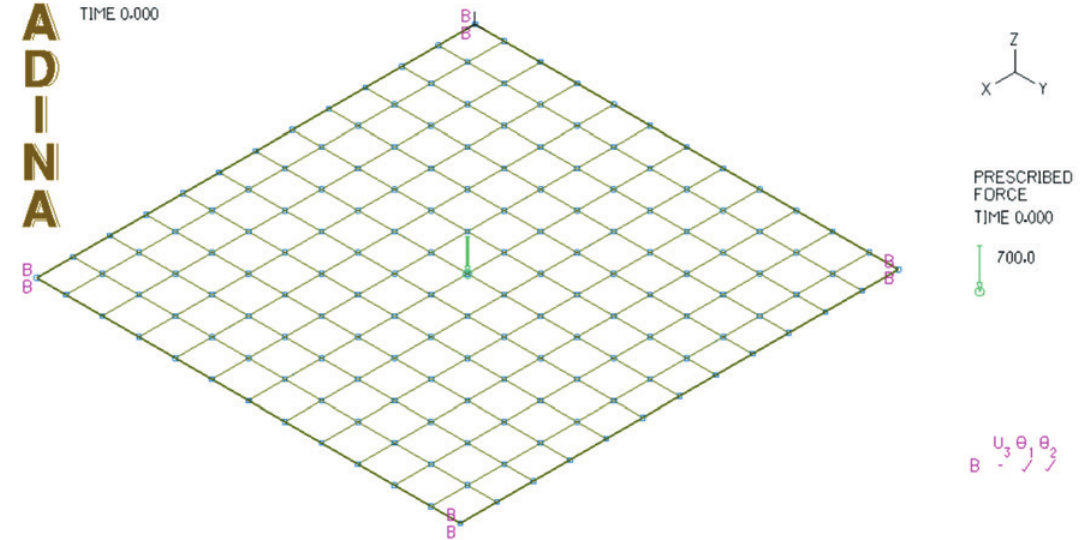
Figura 2 Modelagem pelo programa Adina 9,1 da laje analisada sem TMD's